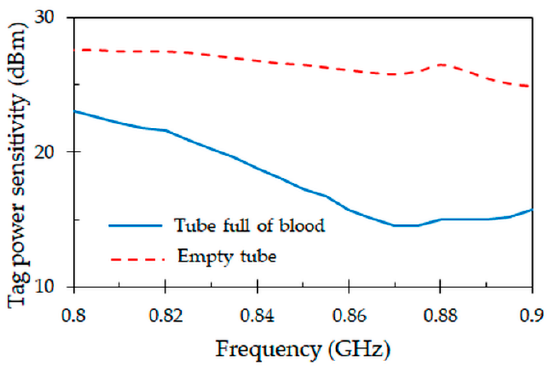
Figure 12. Measured tag power sensitivity obtained for the proposed tag attached to full and empty blood tubes.